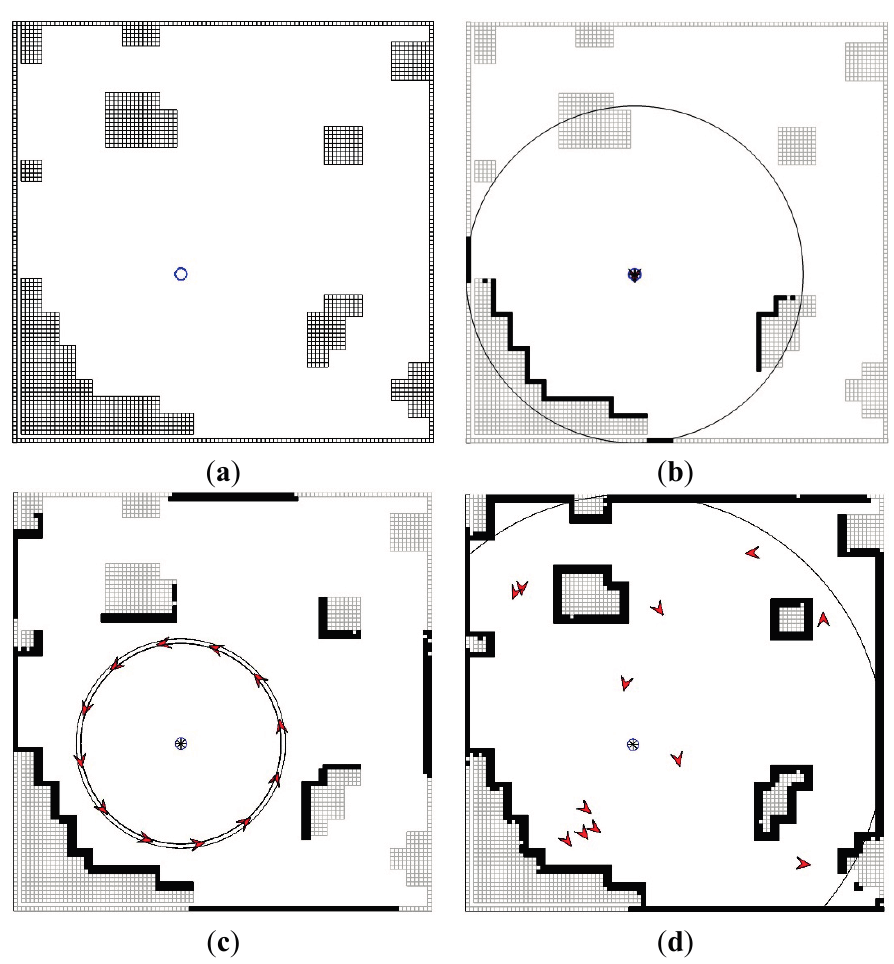
Figure 7. The performance of CESS in the 2D plane. ( a ) The obstacle map; ( b ) The detected obstacles by LRF; ( c ) The detected obstacles by CESS, based on the vision-based positioning system; ( d ) The detected obstacles by CESS based on the UWB-based positioning